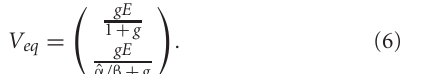
are continued through reset and return to rest, when g ( t ) = 0 after the spike. Also shown ( dots ) are the fixed points V eq ( g k ) , and the trajectories that would be followed without reset if g ( t ) were held at the values g k ( black dot-dashed curves). (B) ( left ) Example of synchronous control. Colors are as in (A) . For comparison to the phase plane ( right ), the times at which g = ( 0 . 3 , 1 . 5 , 12 ) are marked with blue , green , and light blue dots. At these times, the trajectory from the common voltage towards V eq ( g ) is tangent to the diagonal. Parameters chosen for visualization are ˆ α = 0 . 27, β = 0 . 9, and E = 1 .